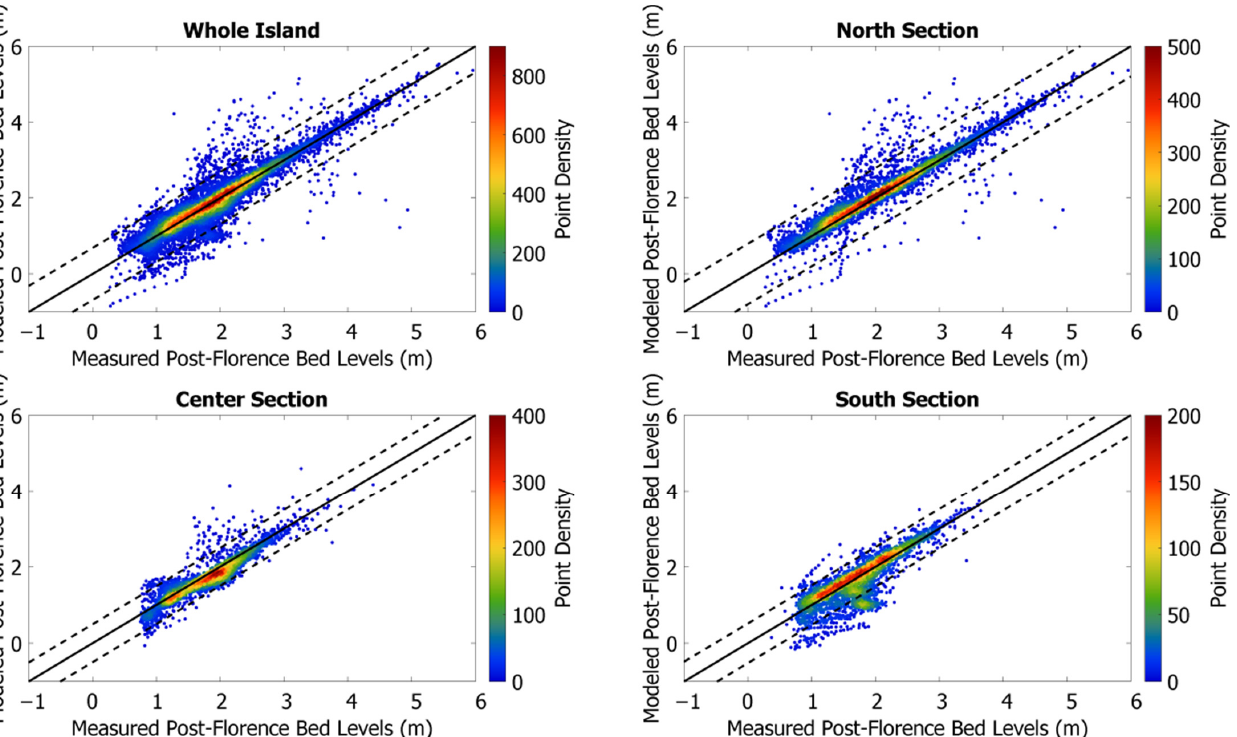
Figure 5. Density scatter plots comparing measured and modeled post-Florence bed levels for the different sections of Masonboro Island from the baseline simulation. The solid black line through the origin shows a 1:1 relationship between measured and modeled elevations; the dashed black lines show one standard deviation for the measured data from the 1:1 line.